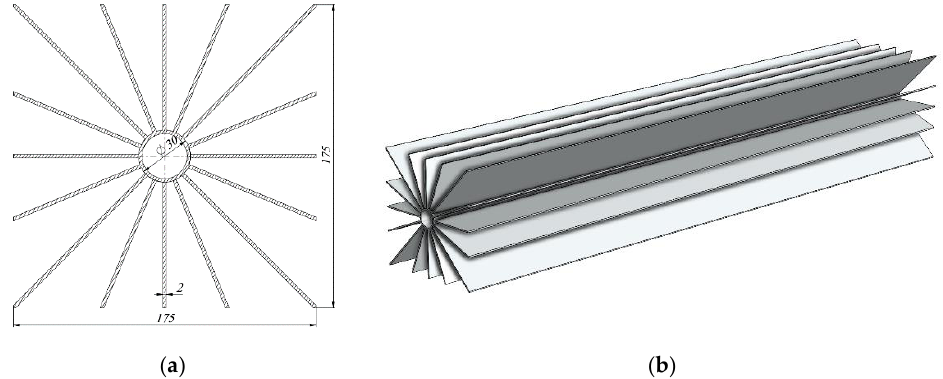
Figure 2. Aluminum finned tube with 16 fins, ( a ) Cross-section dimensions; ( b ) 3D geometry.